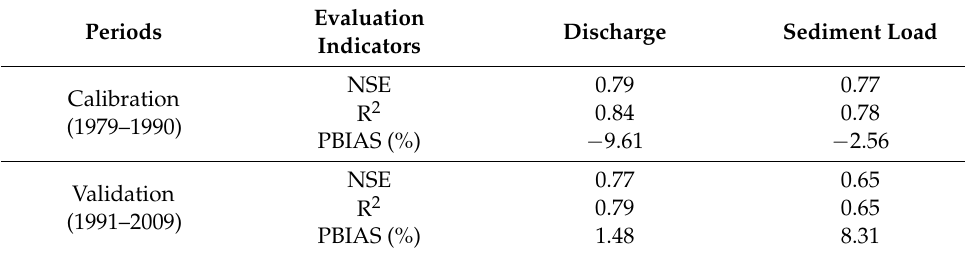
Figure 3. Monthly observed and simulated discharge and sediment load at the Shenyang Hydrologic Station during the calibration (1979–1990) and validation (1991–2009) periods: ( a ) calibration and validation for discharge; ( b ) calibration and validation for sediment load. Table 6. Model calibration and validation